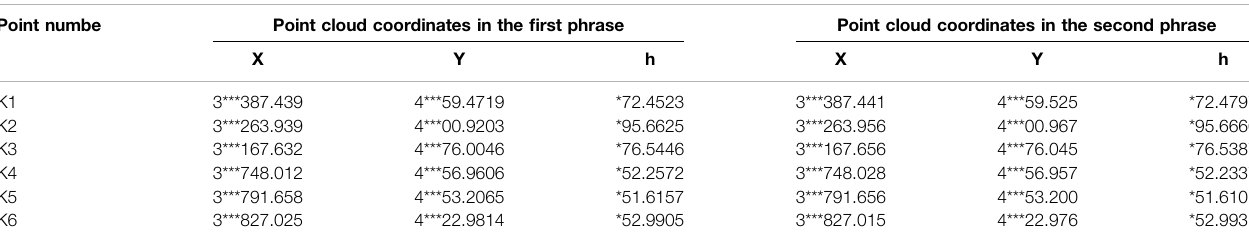
TABLE 4 | Datum point